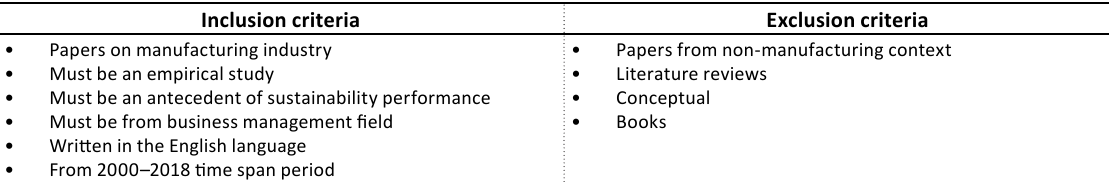
Table 1. Inclusion and exclusion criteria used in the scoping